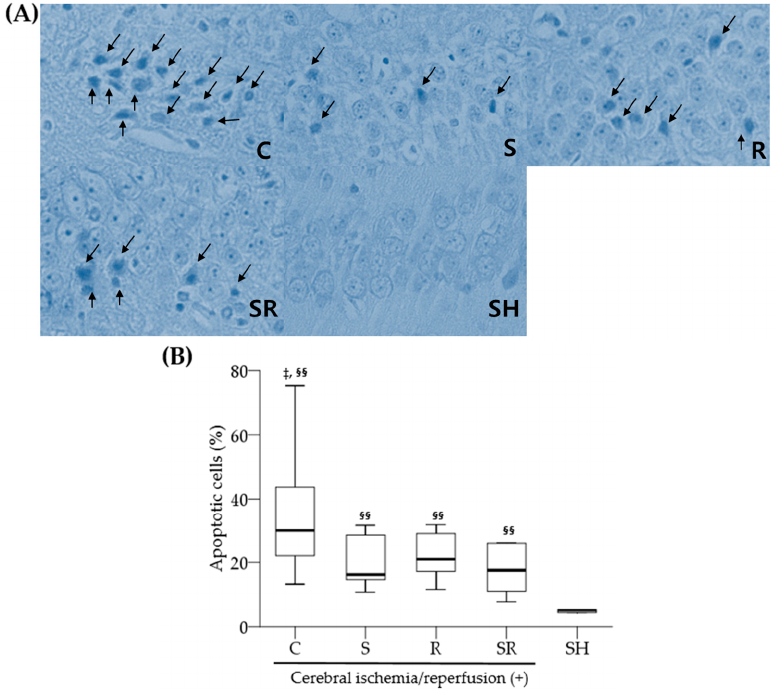
Figure 2. ( A ) Representative photomicrographs (×800) from a single rat with TUNEL staining in the hippocampal CA1 regions one day after transient global cerebral ischemia. Apoptotic cells (arrows) show a blue-stained apoptotic body. ( B ) The percentage of apoptotic cells. §§ p < 0.01 for Group SH; ‡ p < 0.05 for Group SR.